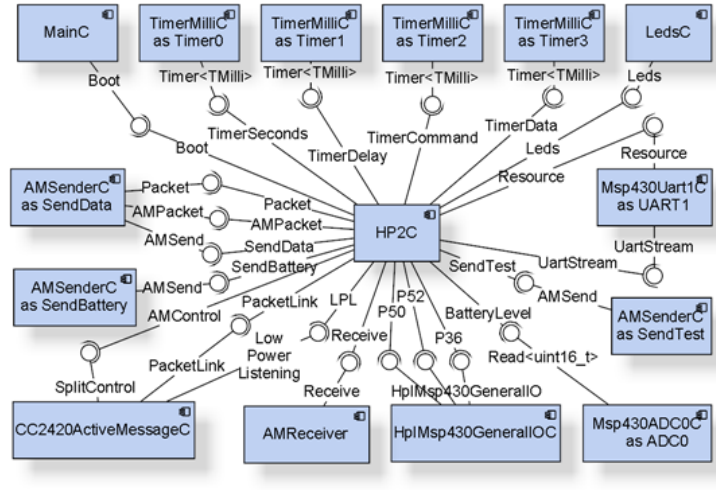
Figure 2. GAIA Soil-Mote: nesC component